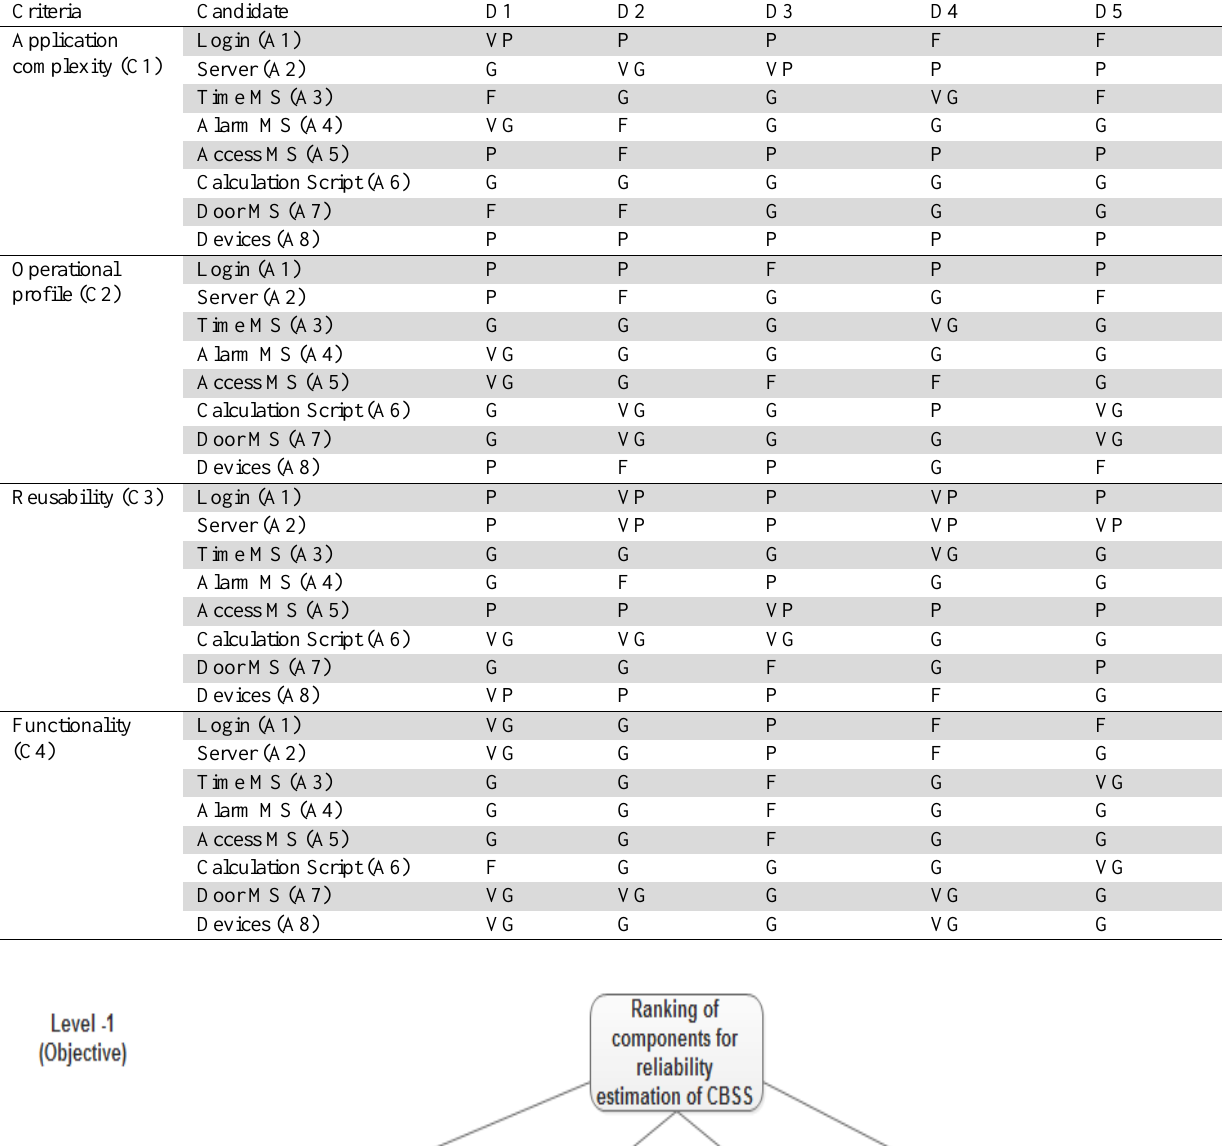
Table 3 Reliability ranking assignment matrix for SMS Criteria